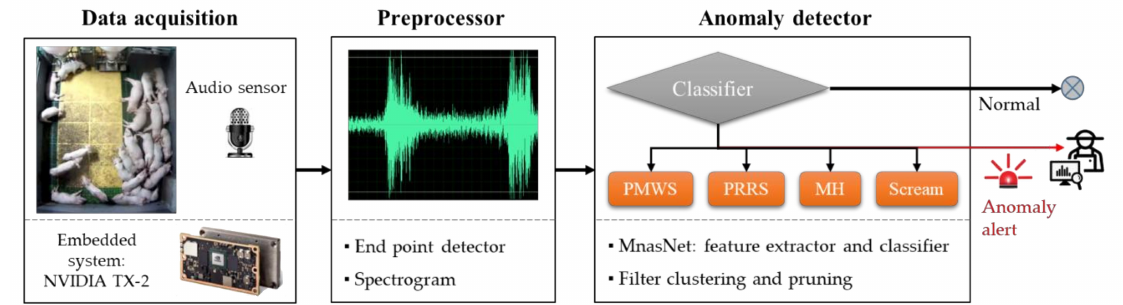
Figure 1. Overall structure of the pig anomaly detection system used to detect postweaning multisystemic wasting syndrome (PMWS), porcine reproductive and respiratory syndrome (PRRS), mycoplasma hyopneumoniae (MH) and